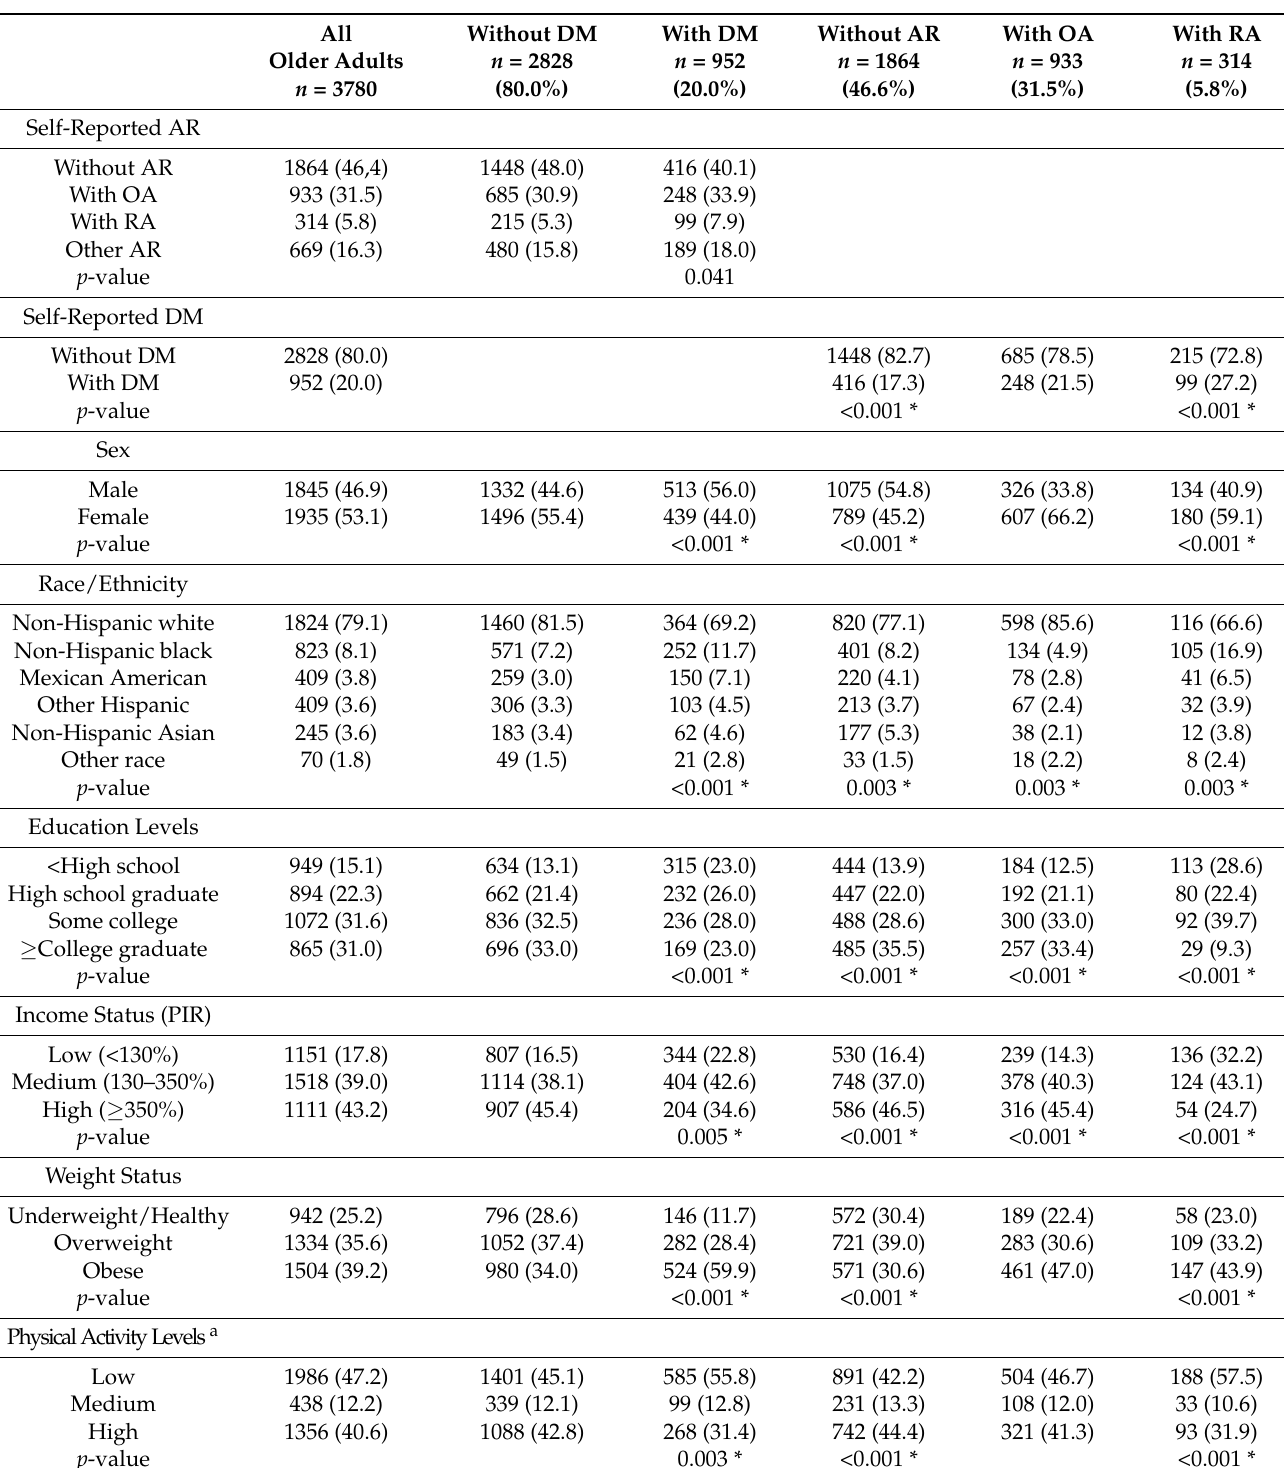
Table 2. Sociodemographic characteristics of older US adults by self-reported diabetes mellitus status and arthritis status: NHANES